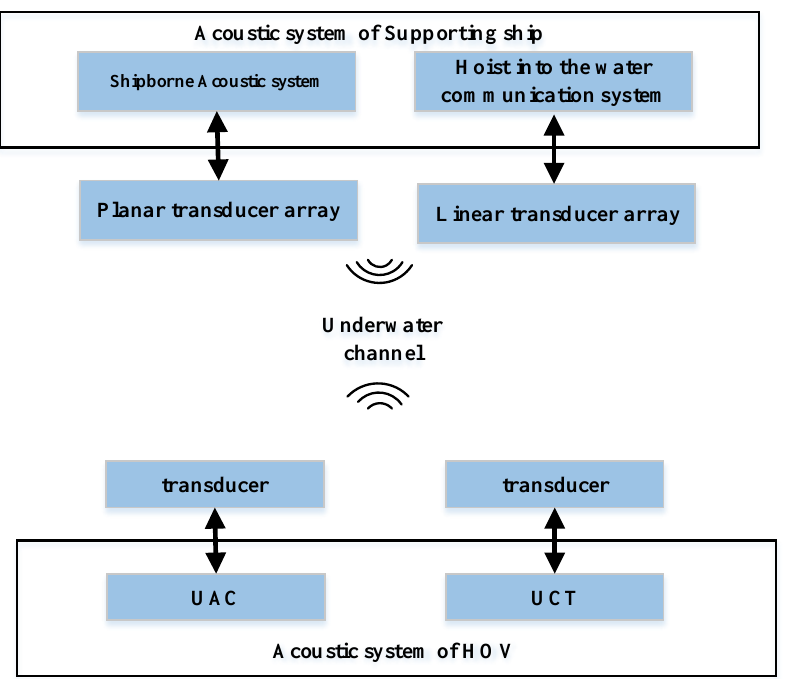
Figure 2. Composition of the underwater acoustic communication system.